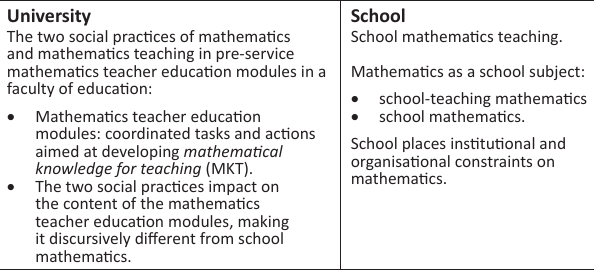
FIGURE 1: A diagrammatic representation of the analytic